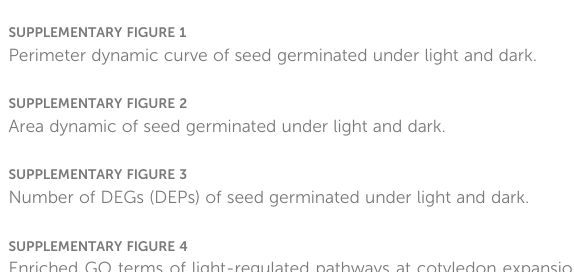
SUPPLEMENTARY FIGURE 1 Perimeter dynamic curve of seed germinated under light and dark. SUPPLEMENTARY FIGURE 2 Area dynamic of seed germinated under light and dark. SUPPLEMENTARY FIGURE 3 Number of DEGs (DEPs) of seed germinated under light and dark. SUPPLEMENTARY FIGURE 4 Enriched GO terms of light-regulated pathways at cotyledon expansion stage. The size of the circle represents the number of genes enriched in the pathway, and the color of the cluster represents the con fi dence interval, and p -value was calculated from hypergeometric